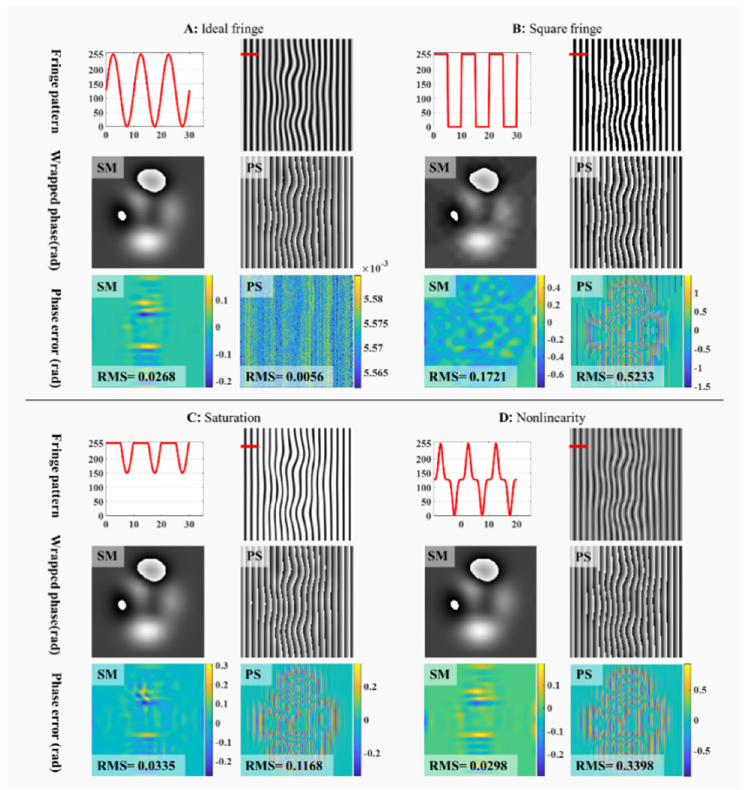
Figure 8. Comparison results of the RMS phase error for different fringe conditions.